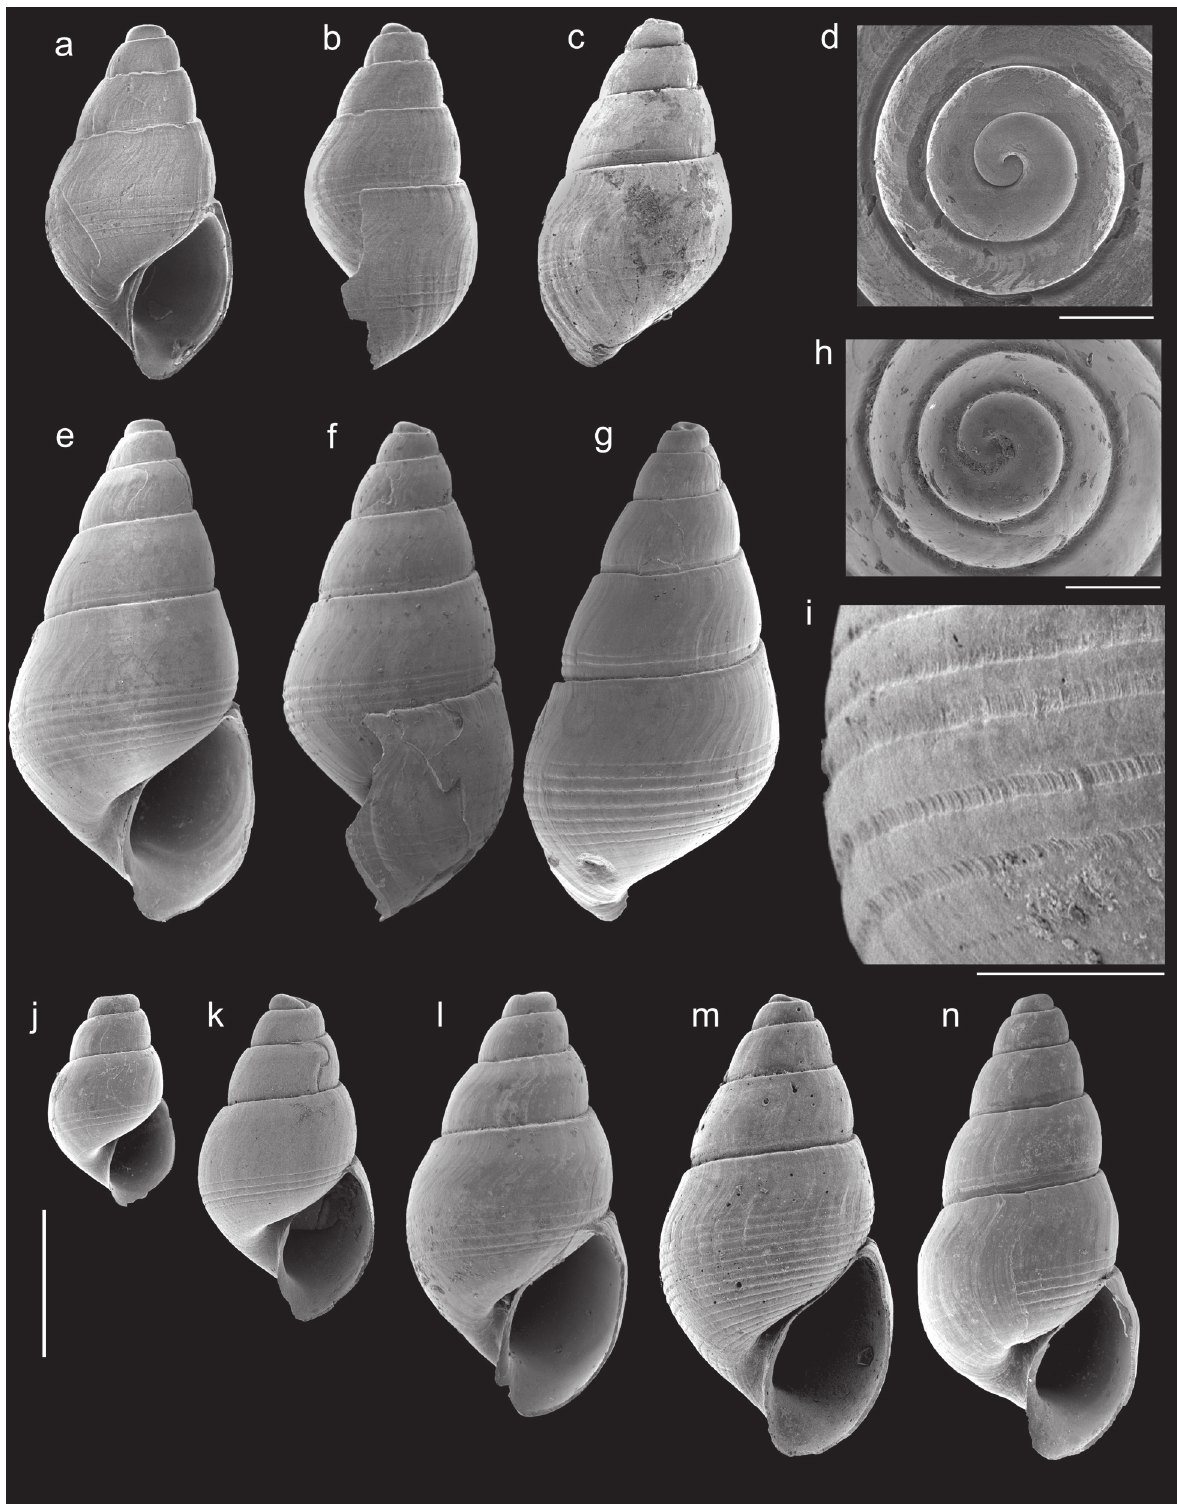
Figure 1. Shells of Ondina semicingulata . A. Syntype (USNM 107913), in apertural view; B. same in lateral view; C. same in ventral view; D. same, detail of protoconch in apical view. E. From Rio Grande do Norte state (MNRJ 27821), in apertural view; F. same, lateral view; G. same, adapertural view; H. same, detail of protoconch in apical view; I. same, detail of sculpture. J. From Brazil, Amapá state (MNRJ 27809), shell #1 in apertural view; K. same, shell #2 in ventral view. L. From Brazil, Bahia state, MNRJ 28264, in apertural view. M. From Brazil, Amapá state (MNRJ 26217), in ventral view. N. From Brazil, Rio Grande do Norte state (MNRJ 27834), in apertural view. Scale bars: whole shells (vertical bar): 1 mm; details (horizontal bar): 200